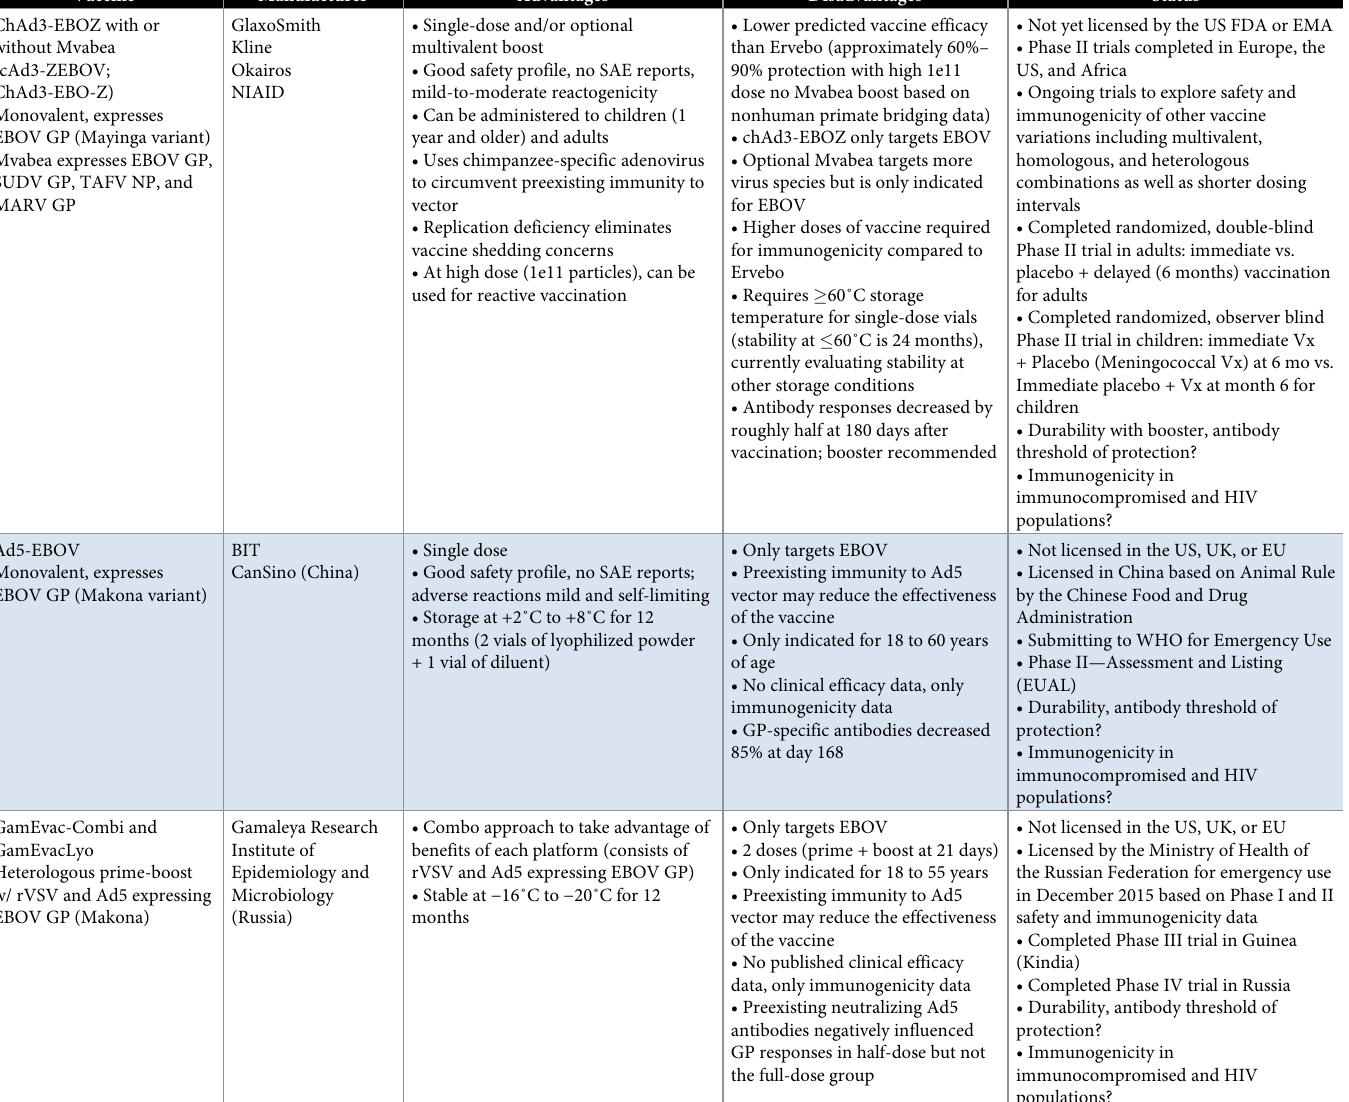
(Fig 1). All 3 platforms use a viral vector, or a modified version of a harmless surrogate virus, to provoke an immune response. Key benefits of virus-vectored vaccines are their ability to deliver antigen specifically to target cells and to induce robust, long-lived immunity.